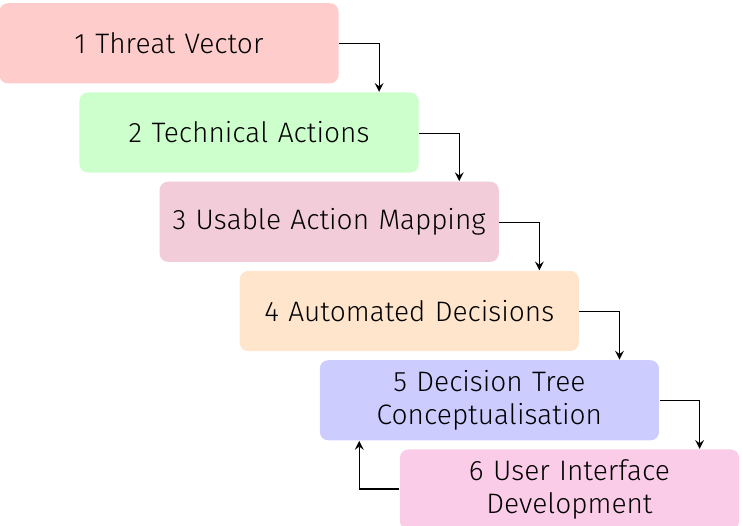
Figure 1. Methodology of User Actions